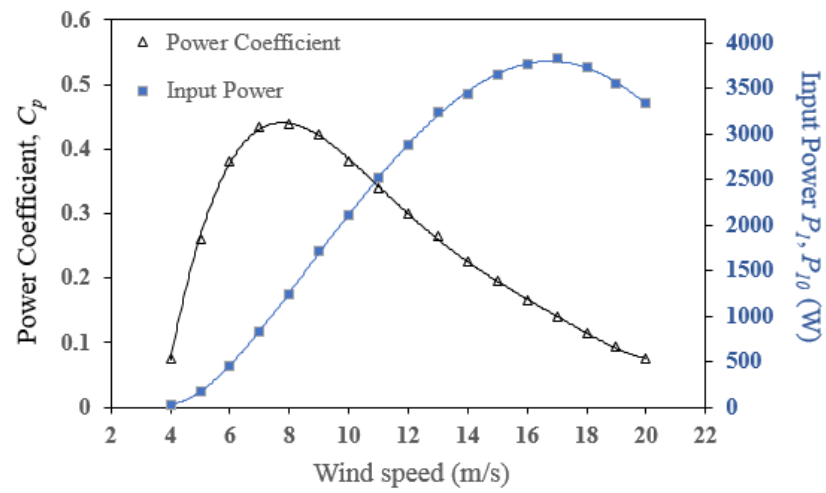
Figure 2. Wind power coefficient and input variations for different wind speeds.